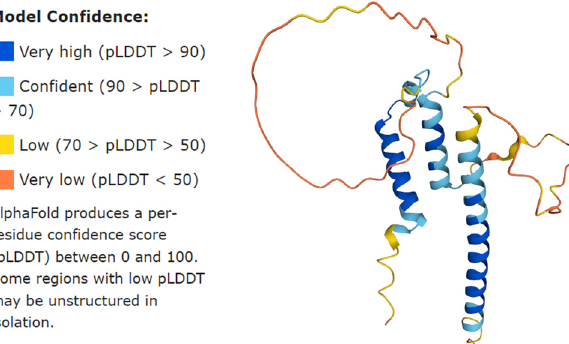
Figure 3: Nonaccurate prediction of a membrane protein by AlphaFold. Amyloid protein precursor ( APP ) is a type 1 membrane glycoprotein with a single TM domain ( left panel ) . The AlphaFold model ( right panel ) is totally